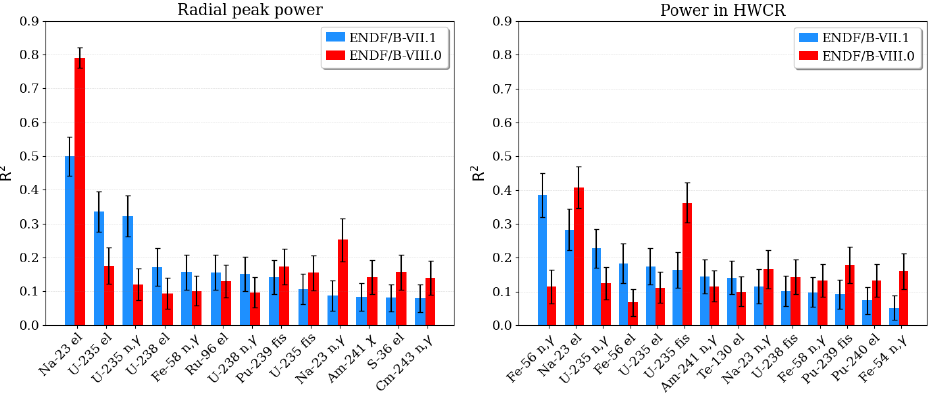
Figure 14. Sampler/KENO-MG top contributor to the peak power uncertainty and to the 05E03 HWCR assembly power uncertainty in terms of R 2